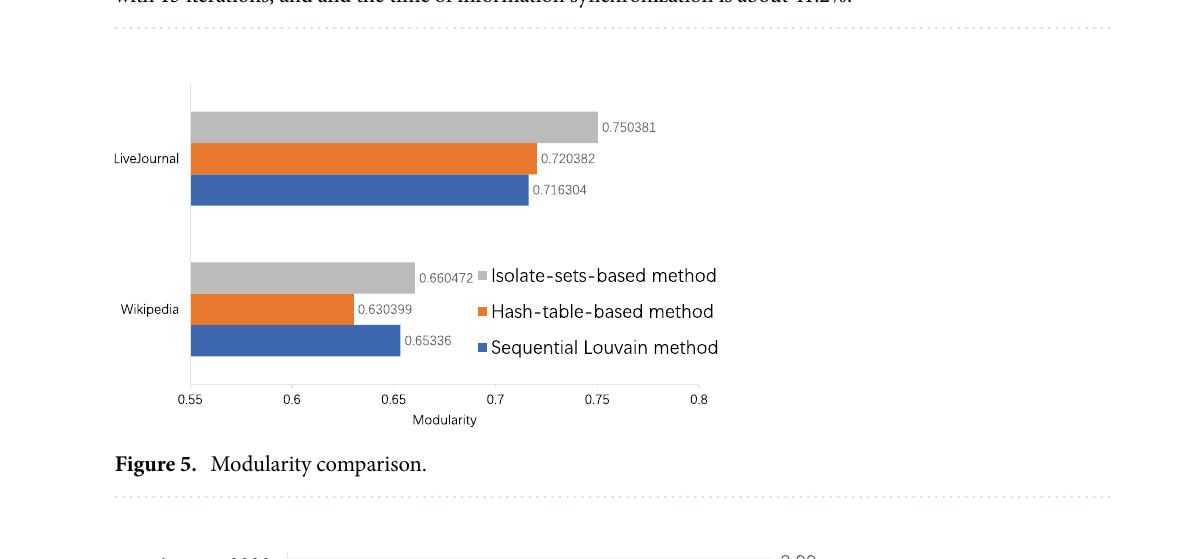
Figure 4. Time breakdown on dataset wikipedia. The time occupation of isolate sets partition is about 6.0% with 13 iterations, and and the time of information synchronization is about 41.2%.